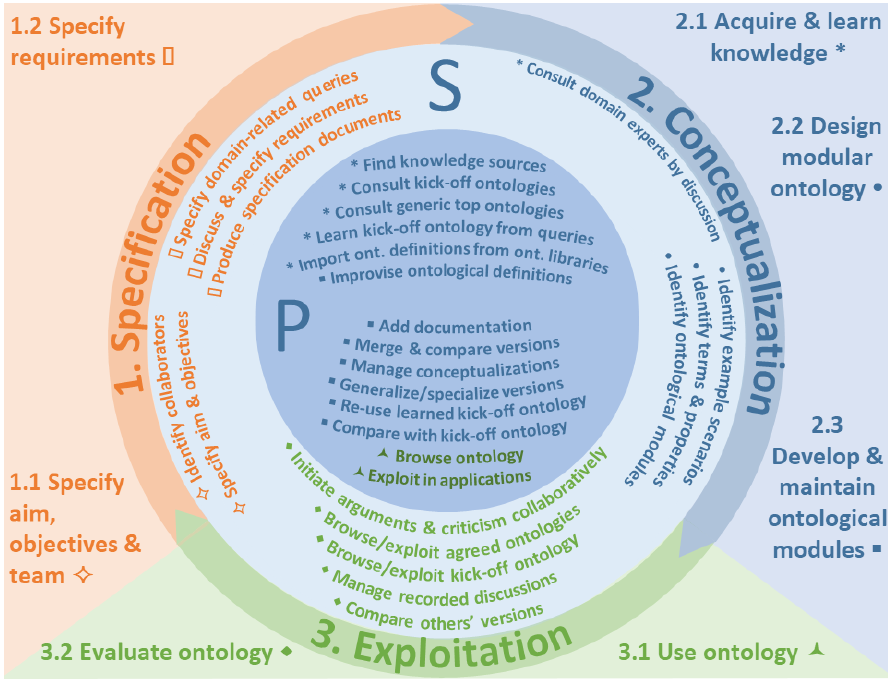
Figure 2. The updated HCOME